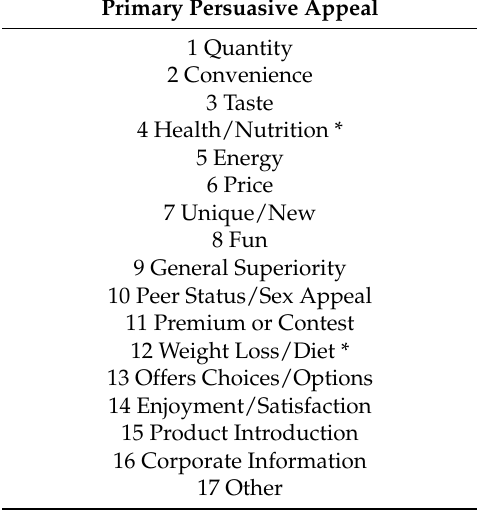
Table A2. Primary persuasive appeals coding system